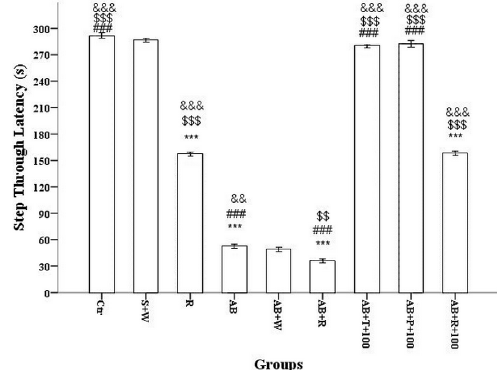
FIGURE 3 - The mean latency to enter the shuttle